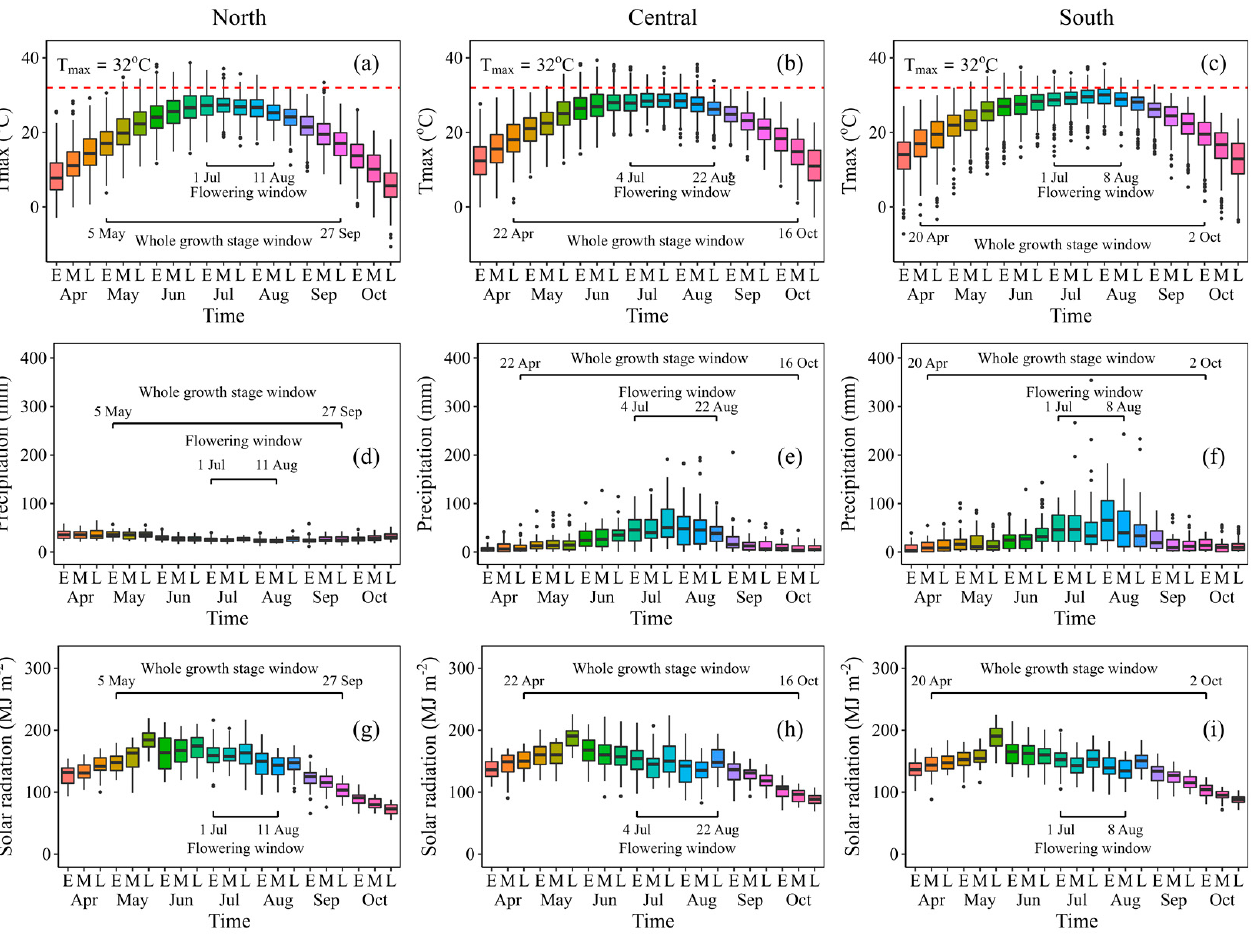
Figure 5. Distribution of maximum temperature (T max ), precipitation and solar radiation in April–October (1980–2019) for the NEC: North, Keshan station ( a , d , g ); Central, Gongzhuling station ( b , e , h ); South, Shenyang station ( c , f , i ). E: the first ten days of a month; M: the middle ten days of a month; L: the last ten days of a month.